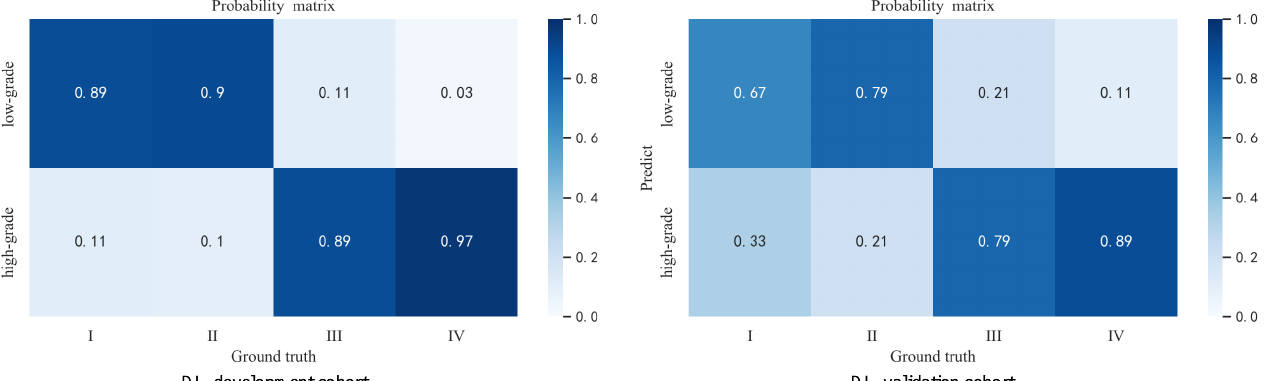
Figure 5. The probability matrix of four grades of patients being predicted to low-grade and high- grade. The subplot in the left is the result in the development cohort. The the subplot on the right is the result in the validation